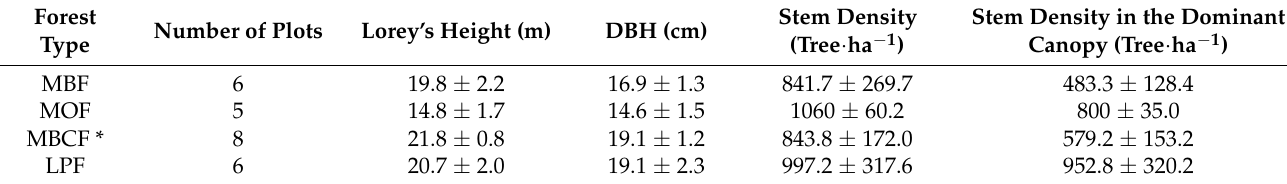
Table 1. General description of the study plots.